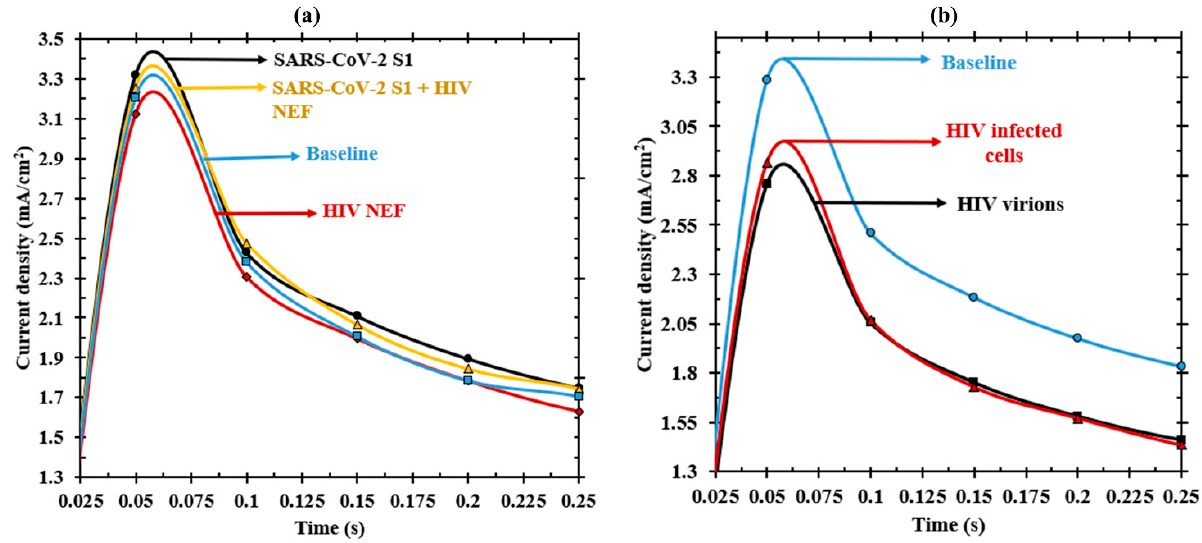
Figure 4. ( a ) Plot showing the electric current responses obtained from HIV NEF protein (red) only, SARS-CoV-2 or COVID-19 S1 protein only (black) and a solution mixed with both these proteins (yellow) as compared to the baseline (no protein). Note that the current obtained from mixed solution had a positive response, meaning the detected current was specific to the SARS-CoV-2 regime. ( b ) Plot showing the electric currents from HIV virions and HIV infected cells being lower than the baseline. This is significant for distinguishing between HIV and SARS-CoV-2 (current responses are higher than baseline) when there is co-infection.